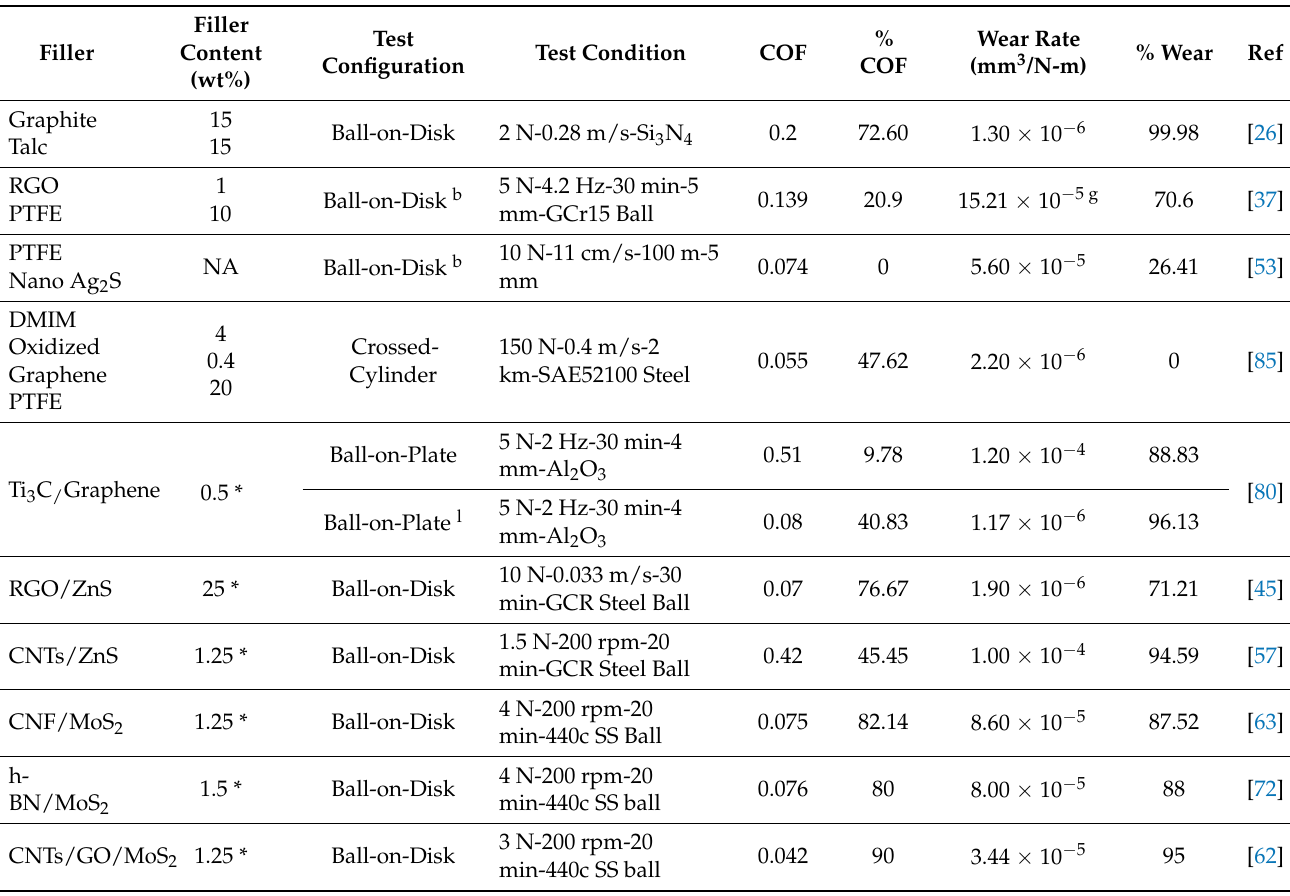
Table 6. Comparison of tribological performance of LBE hybrid composite coatings with pristine epoxy coatings.